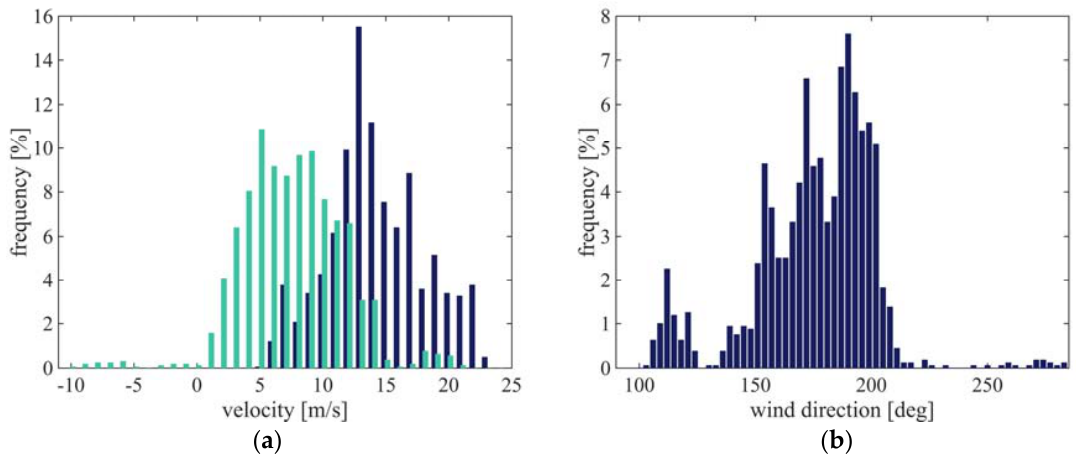
Figure 8. Histogram of 10 min averaged ultrasonic anemometer inflow conditions from 21.12.2013 15:35h (UTC) till 19.01.2014 7:55h (UTC) ( a ) horizontal wind speed in the meteorological reference frame is marked in dark blue, whereas the LiDAR laser beam projected wind speed u lrf (Equation (17)) is shown in green. The bin width is 1 m/s, ( b ) wind direction with a bin width of 3°.